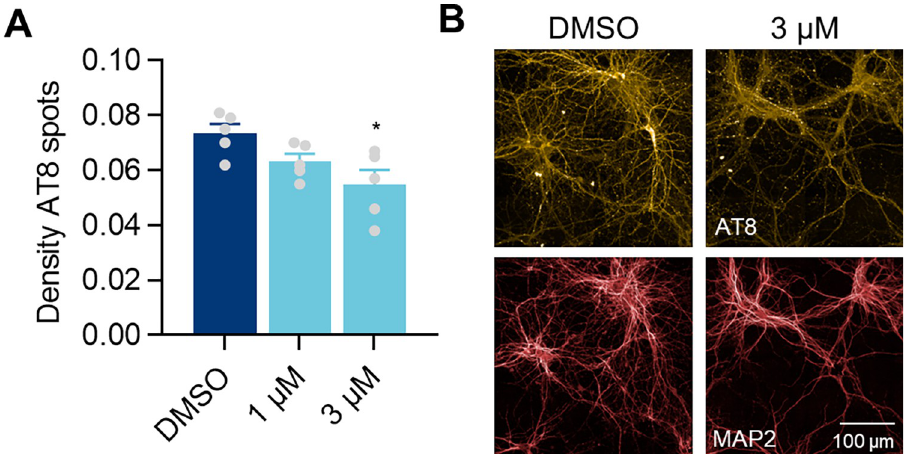
Fig 5. Anle138b prevents tau accumulation in seeded primary neurons. A) Density of Triton-insoluble AT8 spots and representative images ( B ) from hTau primary neurons transduced with T7-P301S LV at DIV4 and treated with P301S lysates at DIV7, in the presence of 1 μ M and 3 μ M of the anti-aggregation compound Anle138b from DIV6. DMSO was used as vehicle. Data shown as mean ± SEM, n = 5 independent experiments. One-Way ANOVA with Dunnett’s multiple comparisons test. All conditions compared with DMSO